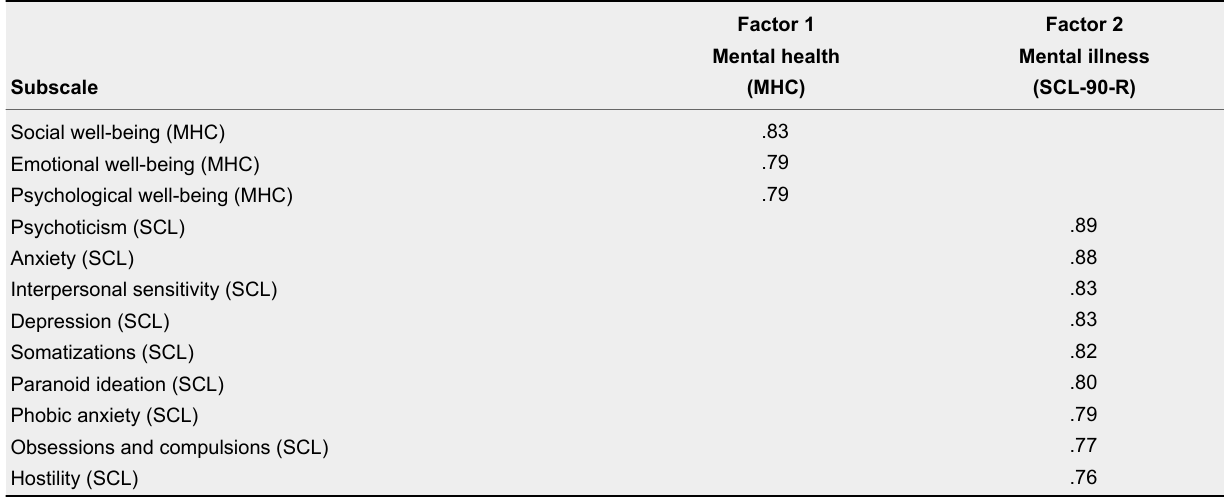
Exploratory Factor Analysis With Two Factors: Mental Health and Mental Illness